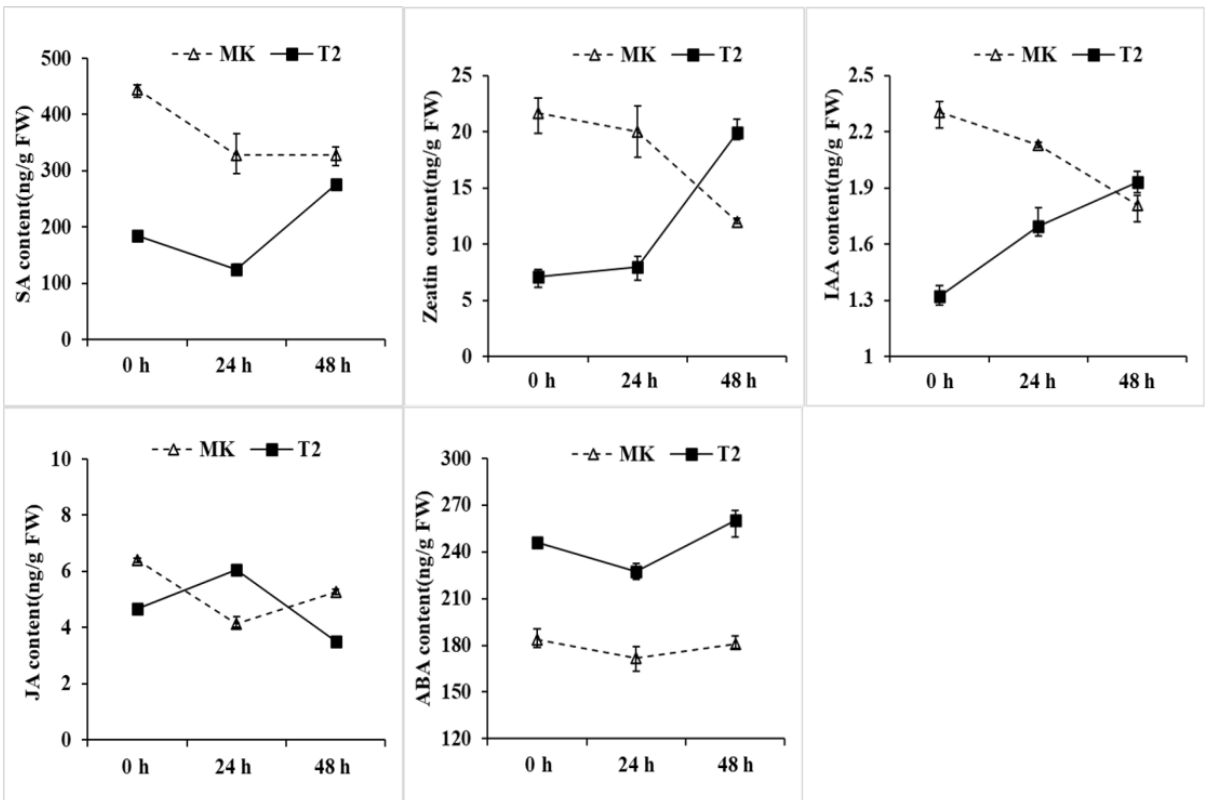
Figure 6. The contents of SA, ZT, IAA, JA, and ABA in the plant leaves after TYLCV infection. The values are the means of three biological replicates ± SD. Vertical bars represent the standard error of the mean of three biological replicates.